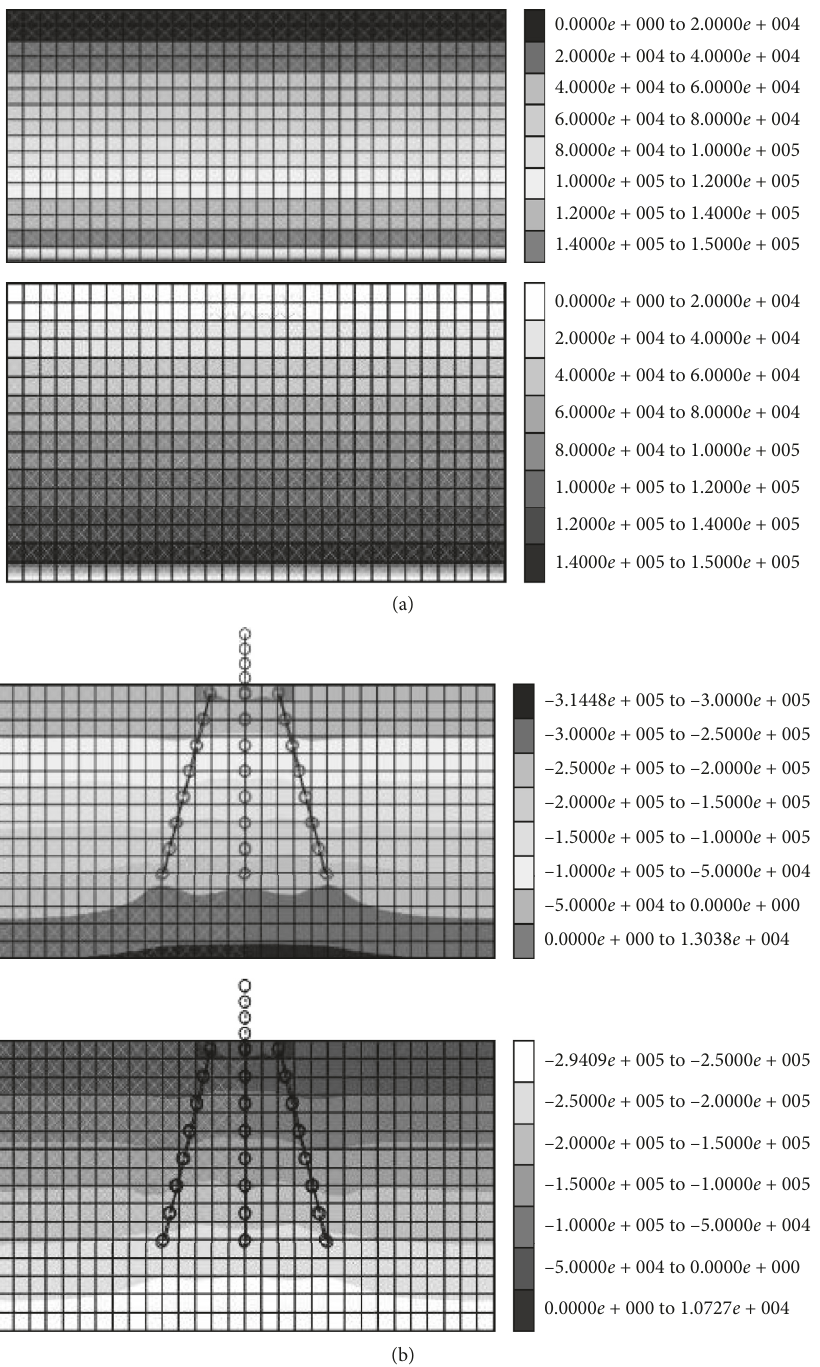
Figure 5: Contour of the pore water pressure and the